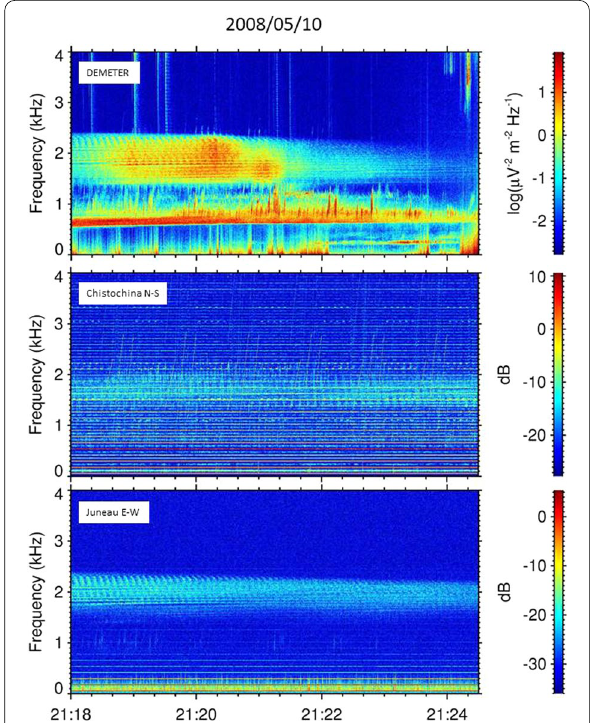
Fig. 25 Spectrograms recorded onboard DEMETER (top panel), at Chistochina (middle panel), and at Juneau (bottom panel) between 21:18:00 and 21:24:30 UT in the frequency range 0–4 kHz. The power spectral density is color-coded according to the scale on the